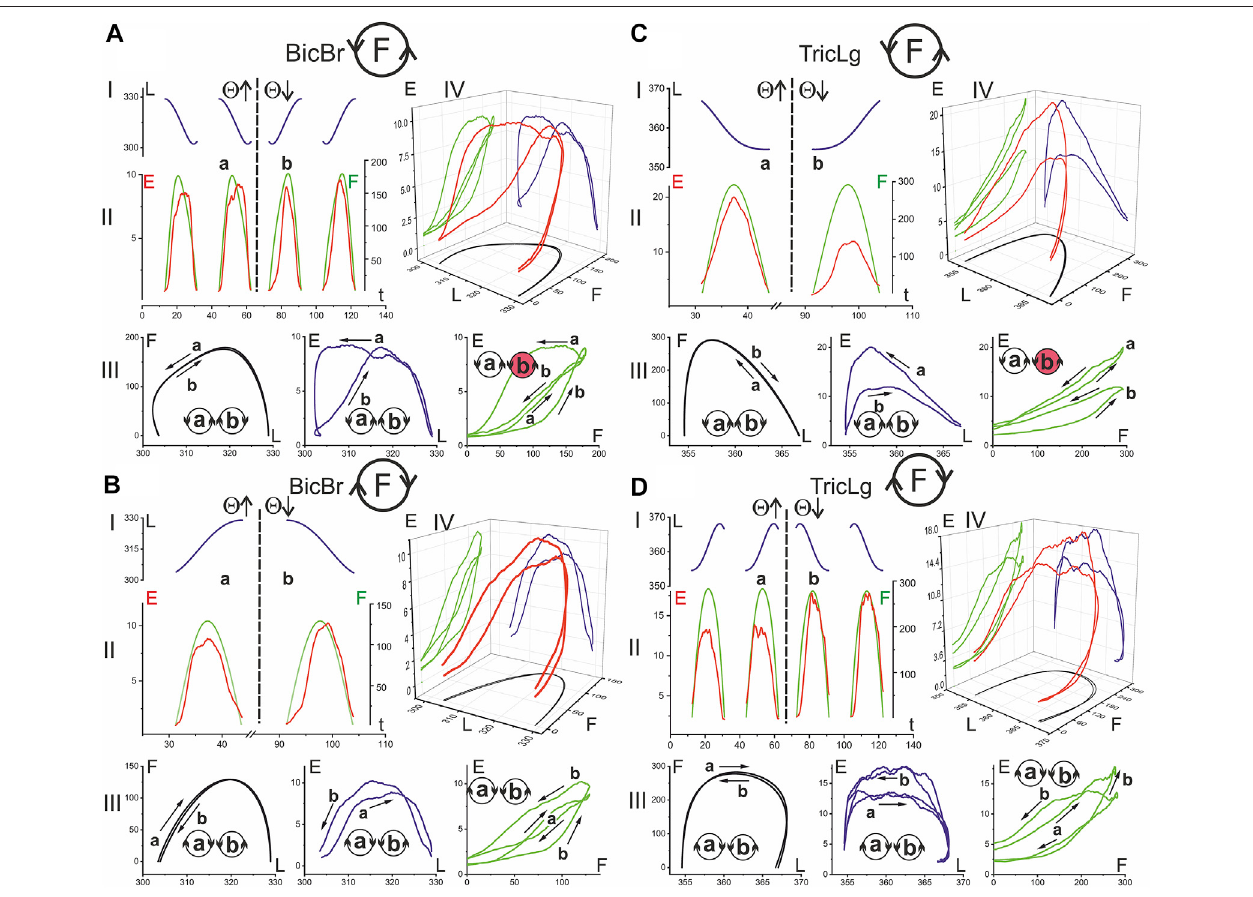
FIGURE 5 | The hysteresis effects in the activity of the elbow muscles: relationship between EMG intensity (E), muscle length (L) and force (F). The data were obtained of subject YKwith identi fi ed bone geometry, repetition ofsix identical tests foraveraging procedure. The analysisis based on the segmentsof time records L(t) (blue) , E(t) (red) , and F(t) (green) , which are allocated strictly within the action zones of the forces generated by the muscle [Panels I, II in (A – D) ]. After reordering the functionaldependencies betweenvariables,the3DtracesoftheEMGintensitychangesarepresented independency ontherespectivemechanicalparametersof the muscles E(L, F) (red color) [panel IV in (A – D) ]. Functional dependencies F (L), E (L), and E (F) are de fi ned as projections of three-dimensional traces on coordinate plates, and they are displayed in the respective colors: black, blue, and green [panels III in (A – D) ]. Other designations: the circle with letter F inside designates the force direction in respective movement tests (A – D) ; a and b are the phases of the test movement coinciding with rising ( Θ ↑ ) and falling ( Θ ↓ ) branches of the turning angle change;thecircles withletters aand b insidedesignatethedirectionsoftherespectivehysteresisloops(the directions mainlycoincidefor differentpairs ofvariables with the exception of those marked in red). A continuation of the presentation of this experiment for the shoulder muscles is shown in Figure 6